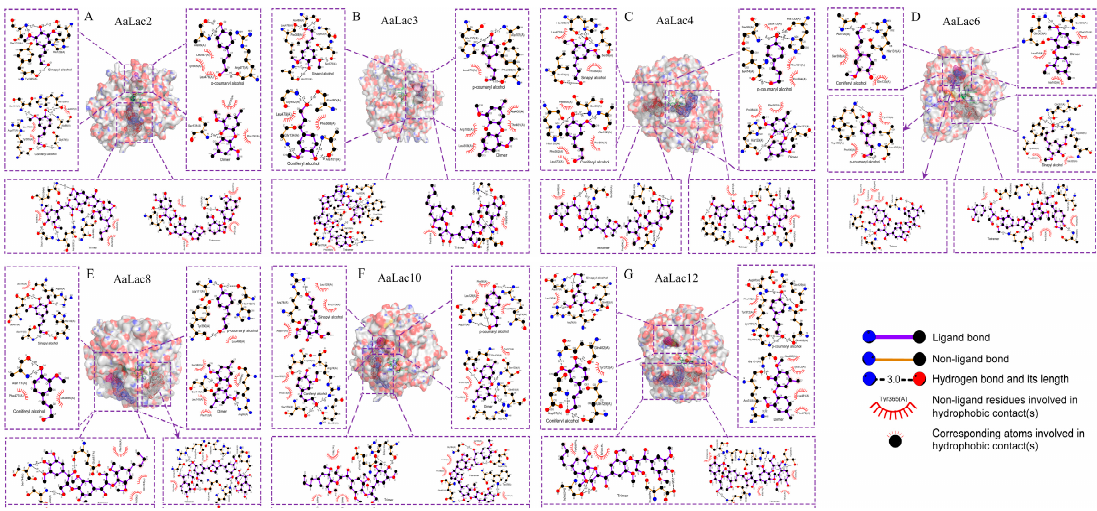
Figure 6. Interactions of A. areolatum laccase with lignin model compounds: sinapyl alcohol (SA), coniferyl alcohol (CA), p-coumaryl alcohol (CoA), guaiacyl 4-O-5 guaiacyl (dimer), syringyl β -O-4 syringyl β -O-4 sinapyl alcohol (trimer), and guaiacyl β -O-4 syringyl β - β syringyl β -O-4 guaiacyl (tetramer). ( A ) AaLac2; ( B ) AaLac3; ( C ) AaLac4; ( D ) AaLac6; ( E ) AaLac8; ( F ) AaLac10; ( G )